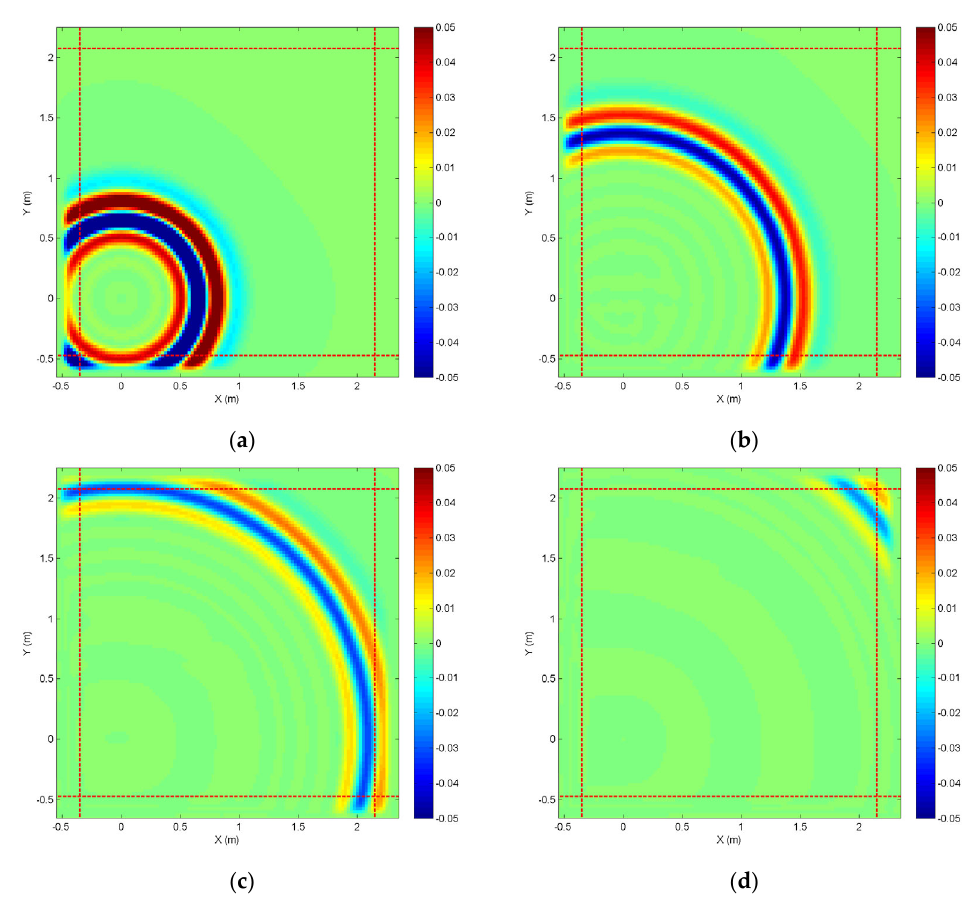
Figure 2. Dynamic process in the Z ‐ FDTD iteration: ( a ) n t = 100; ( b ) n t = 150; ( c ) n t = 200; ( d ) n t = 250. As obviously seen in Figure 2a, those electromagnetic waves have propagated and penetrated into the lower ‐ left PML regions when the iterative time step n t = 100, and no distinct reflection is found. Afterward in Figure 2b, those lower ‐ left electromagnetic waves have all been absorbed and the only upper ‐ right waves are still propagating. Ac ‐ cording to the deduction from the 3D view, no reflection occurred in the cross ‐ section Z = 0 m is influenced by the wave propagation from the bottom PML region; therefore, the smooth circular ‐ arc ‐ shaped electromagnetic diffusion can be still maintained. When the time step n t = 200 in FDTD iteration, it can be seen that the electromagnetic diffusion starts to knock against upper ‐ right PML regions in Figure 2c. Eventually, those waves in the whole FDTD domain are fully attenuated after time step n t = 250, as observed in Fig ‐ ure 2d.